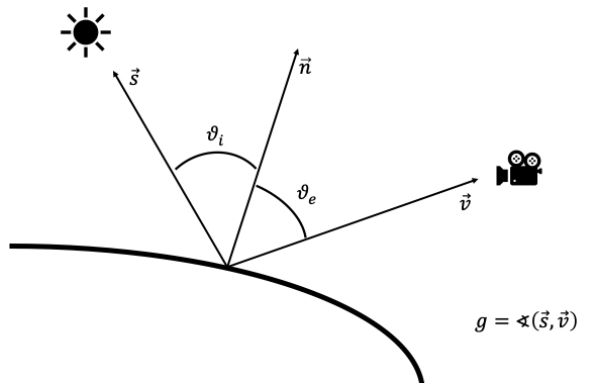
Figure 1. Illumination and viewing